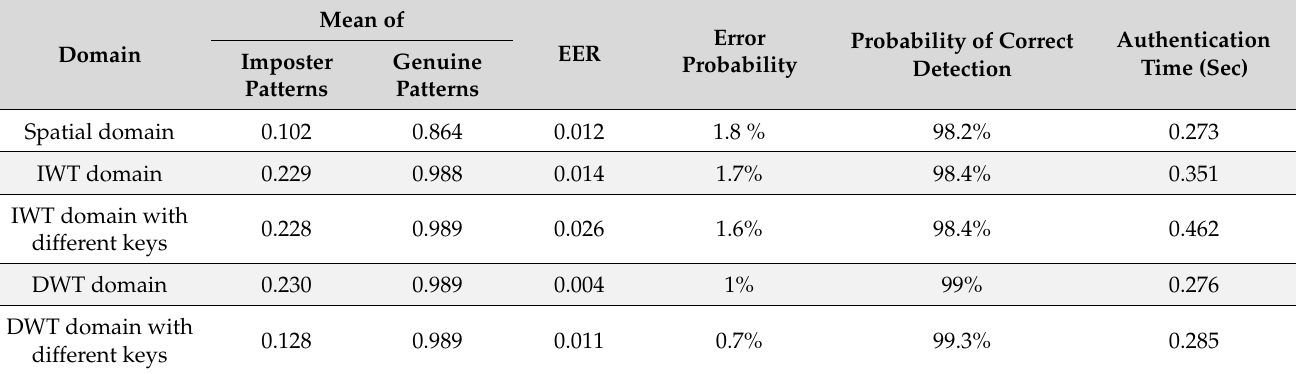
Figure 14. The ROC curve for the system using Baker map and an encrypted kernel with ( a ) circular encryption, ( b ) IWT encryption with similar keys for all sub-bands, ( c ) IWT encryption wih different keys for all sub-bands, ( d ) DWT encryption with similar keys for all sub-bands, ( e ) DWT encryption with different keys for all sub-bands. Table 3. The encryption domain effect using several transforms. Table 4. The encryption domain effect using a modified logistic